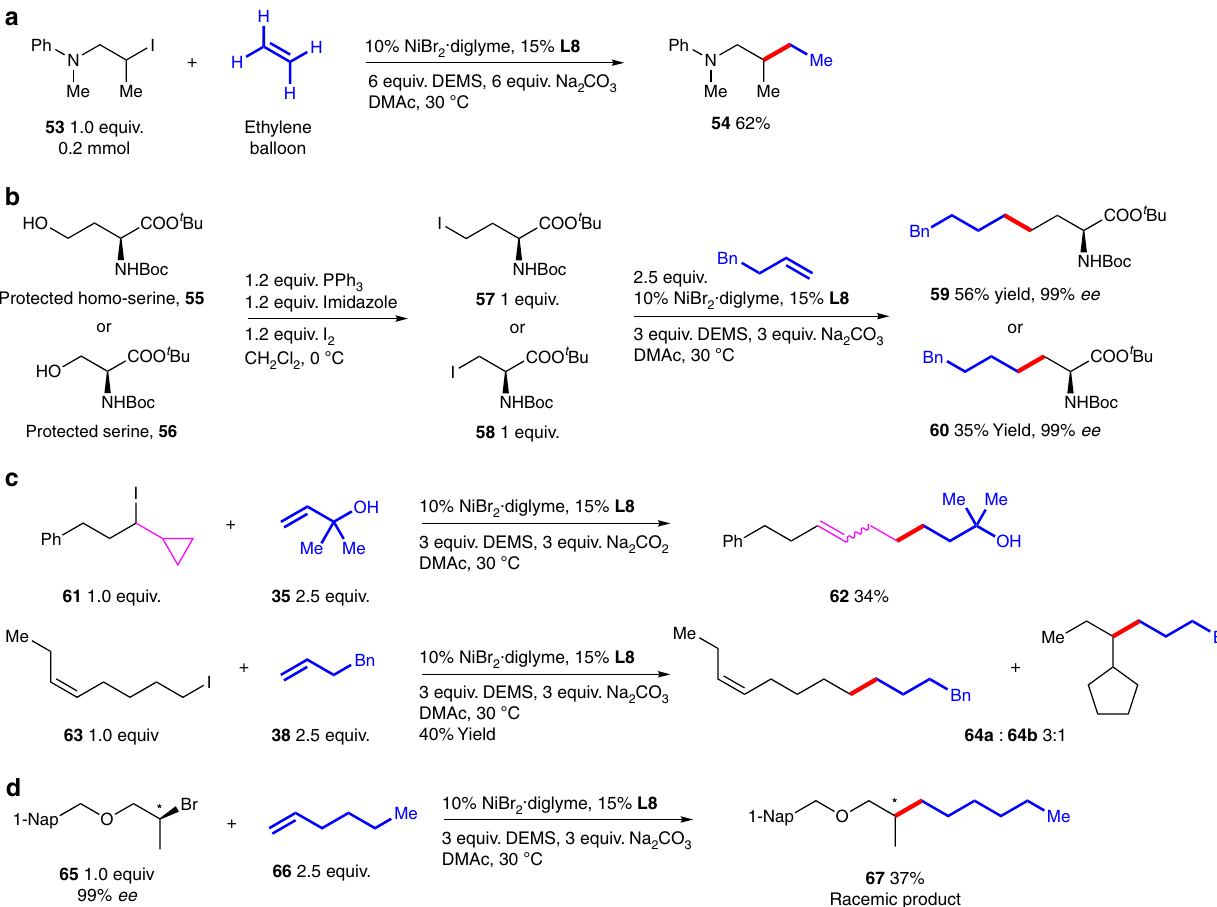
Figure 3 | Other applications of reductive olefin hydrocarbonation reaction. ( a ) Conversion of ethylene. ( b ) Synthesis of non-natural amino acids. ( c ) Radical clock experiments. ( d ) Stereochemistry of reductive olefin hydrocarbonation reaction. Nap, naphthyl.